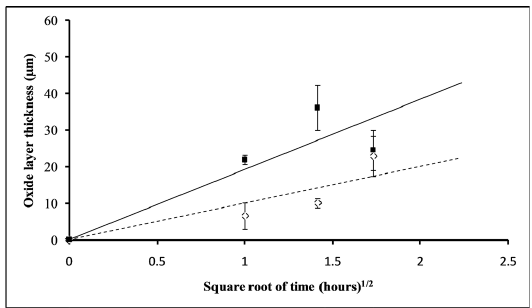
Figure 6. Variation of the oxide layer thickness (μm) with the time (hours) based on the parabolic model for Cu-32.02% Zn-2.30% Pb alloy that is thermally oxidized in N N -12 wt.% O atmosphere 2 2